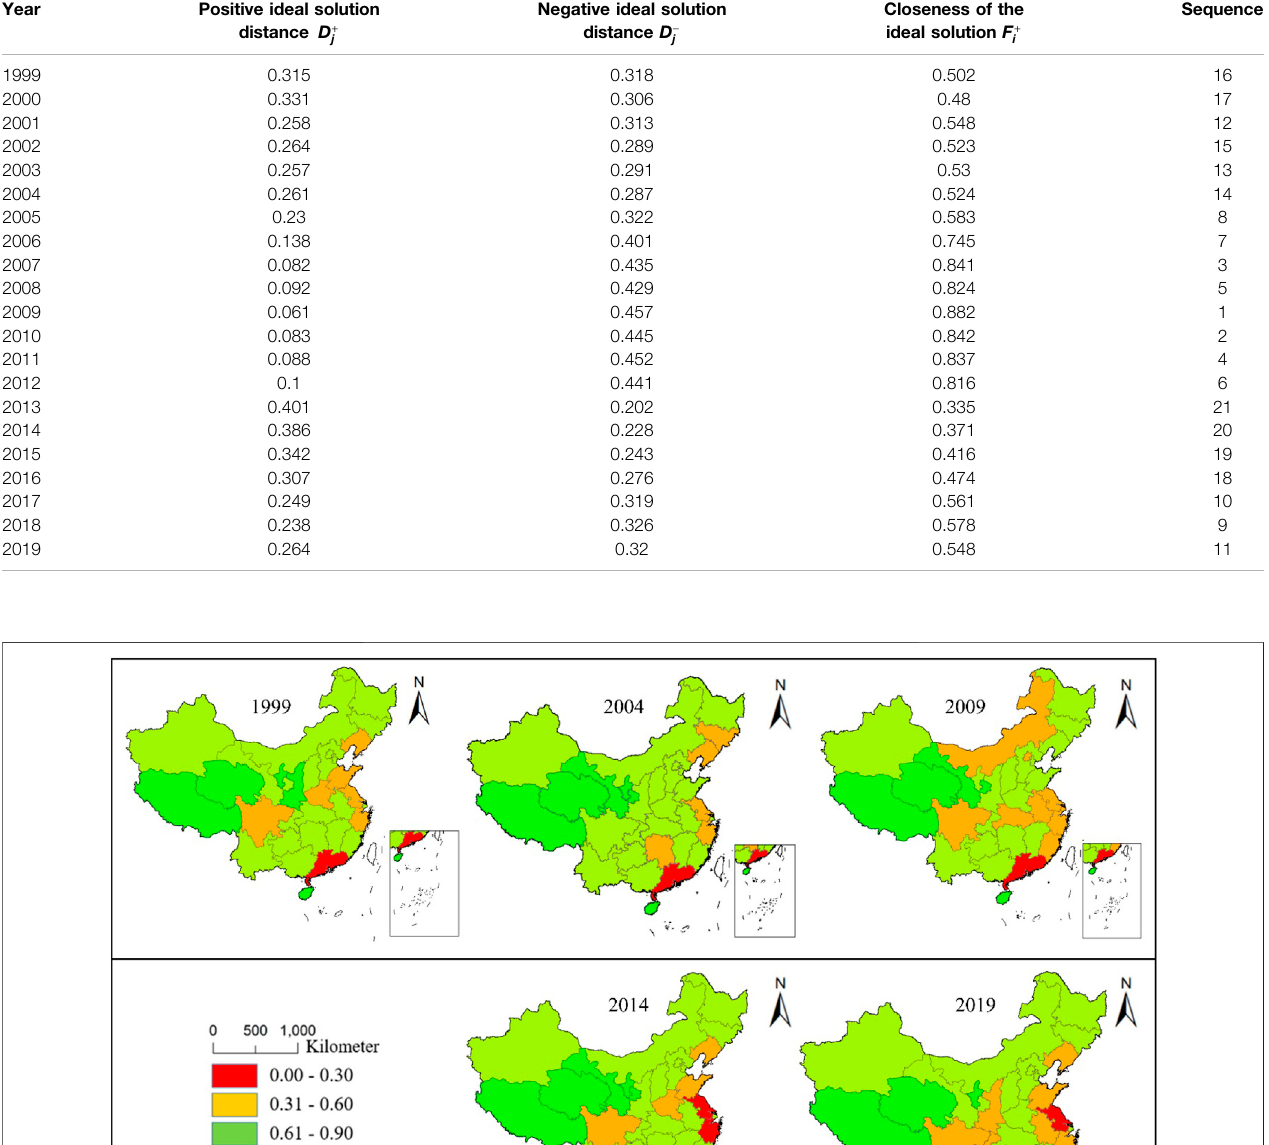
Closeness of the ideal solution F + i